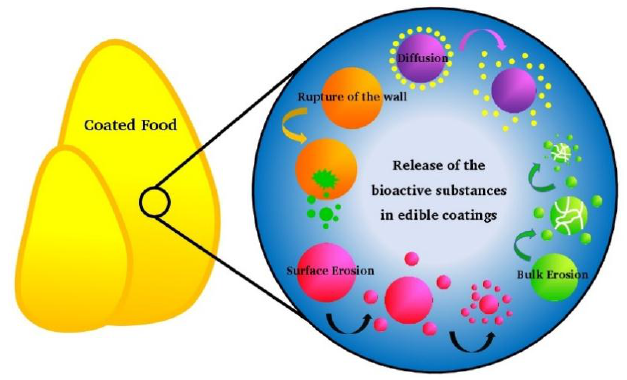
Figure 1. Release process in edible coatings incorporated with functionalized nanostructures.